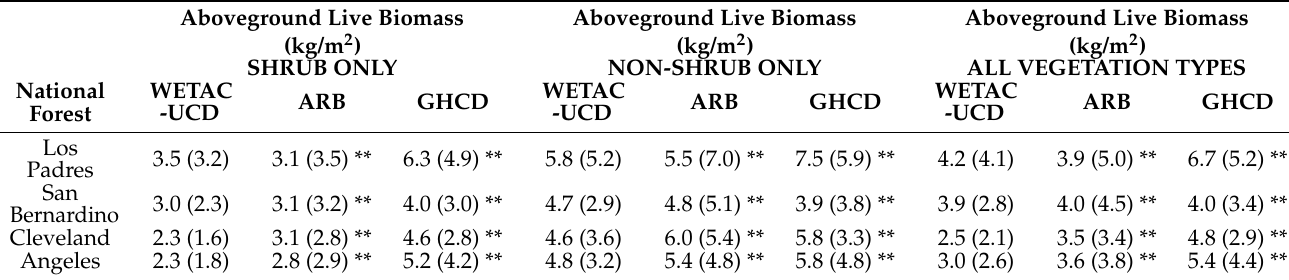
Table 4. Mean total aboveground live biomass (AGLBM) estimates for the year 2010 for the four national forests in the study area using the methods developed in this paper (WETAC-UCD), the California Air Resources Board (ARB) [61], and the University of Wisconsin-Madison (GHCD) [60]. Mean biomass values (kg/m 2 ) for each forest were calculated from the 30 m resolution raster layers developed using each of the three methods. The corresponding standard deviation values are in parentheses. Two-sample t -tests for differences in means were conducted between the ARB and the GHCD AGLBM means and the WETAC-UCD means. Mean biomass was calculated for three CWHR vegetation classes: shrub only (mixed chaparral, chamise-redshank chaparral, and coastal scrub), non-shrub (all types, excluding mixed chaparral, chamise-redshank chaparral, and coastal scrub), and all CWHR vegetation types. Aboveground Live Biomass Aboveground Live Biomass Aboveground Live Biomass (kg/m 2 ) (kg/m 2 ) (kg/m 2 ) SHRUB ONLY NON-SHRUB ONLY ALL VEGETATION